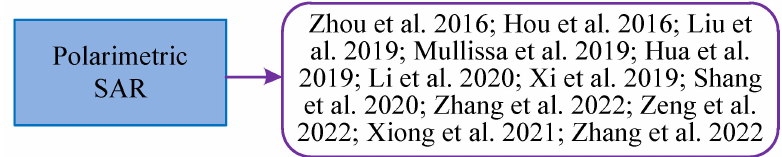
Figure 23. The polarimetric SAR ATR